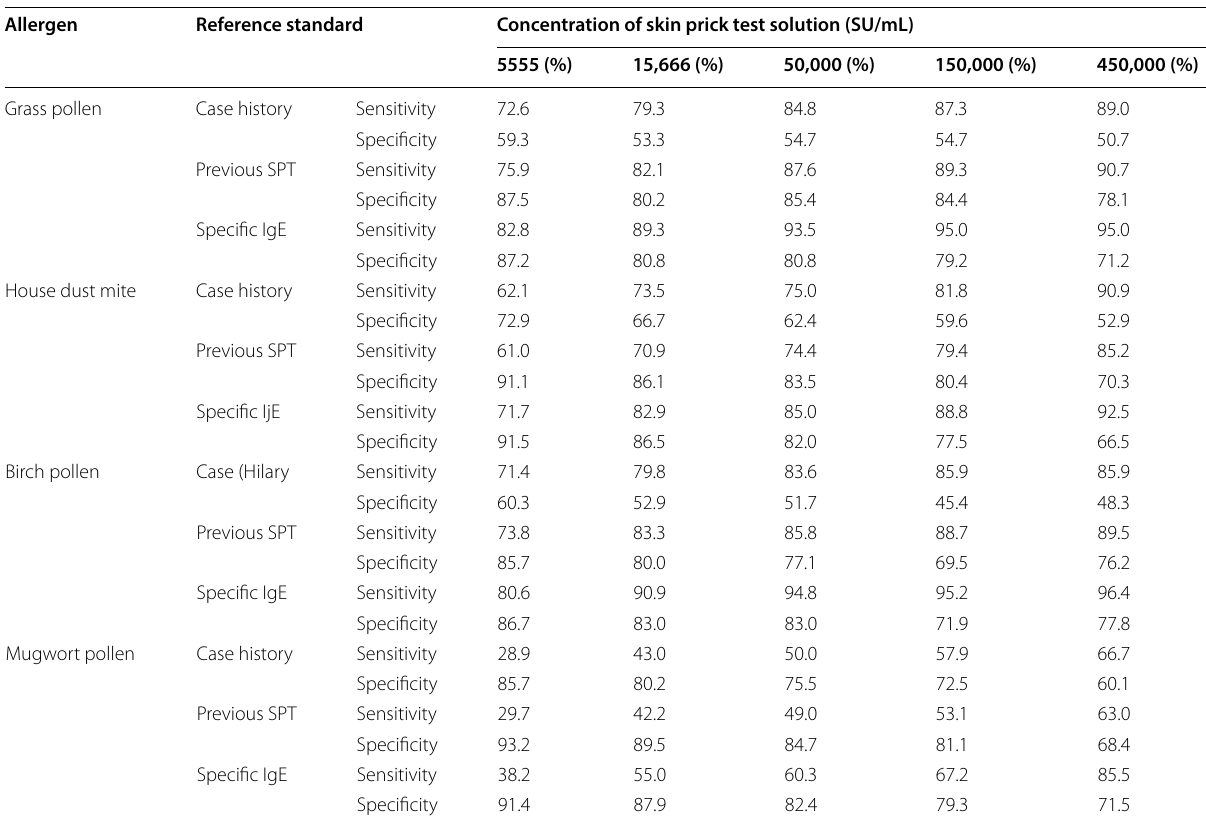
Table 3 Sensitivity and specificity for all allergens estimated up against the three reference standards in five different concentrations